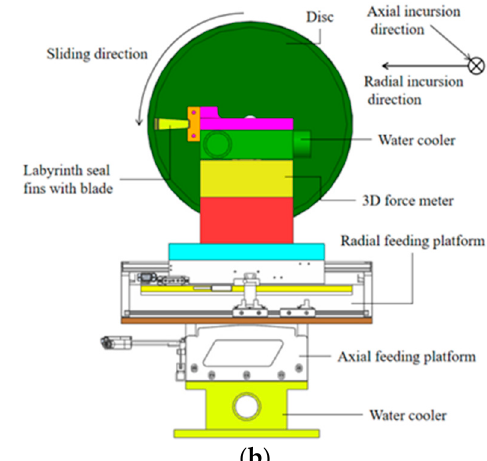
Figure 4. Incursion control and test measurement. ( a ) Measurement of temperature and force. ( b ) Figure 3. Installation of honeycomb. Schematic diagram of incursion control.